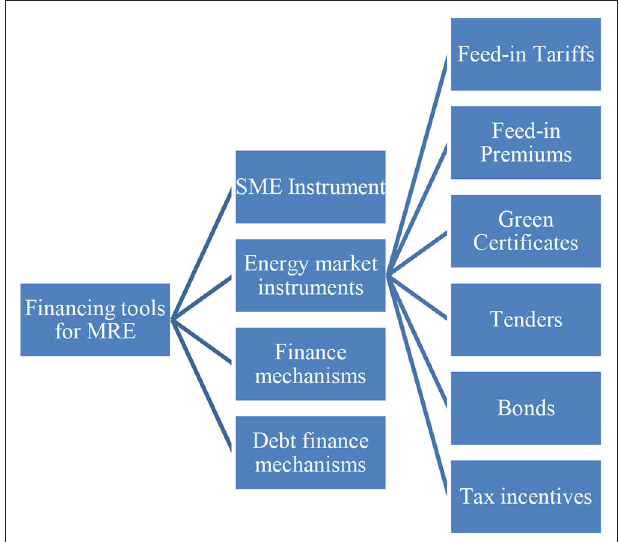
FIGURE 4 | The financing tools for